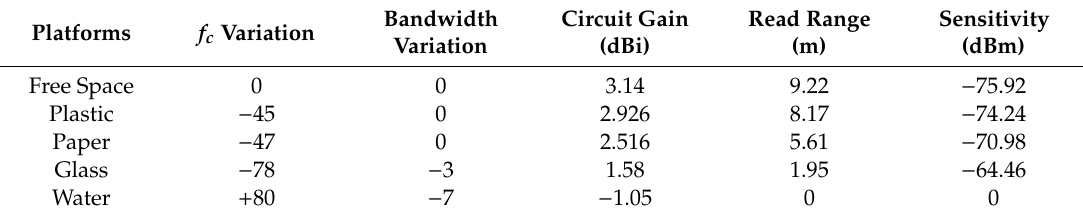
Table 6. North American UHF RFID tag performance on several platforms and in free space.